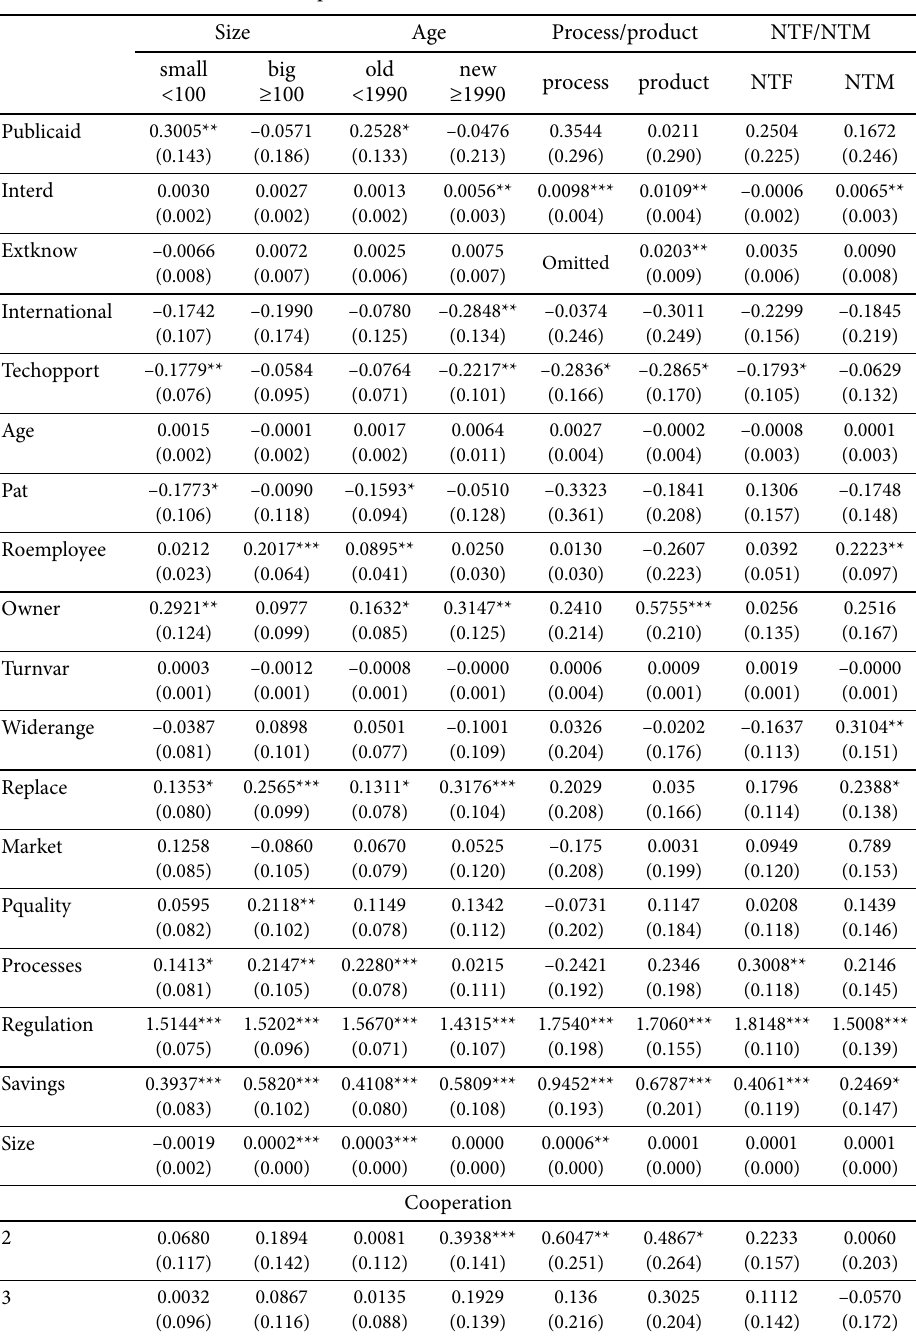
Table A4. Coefficient results of the probit model with instrumental